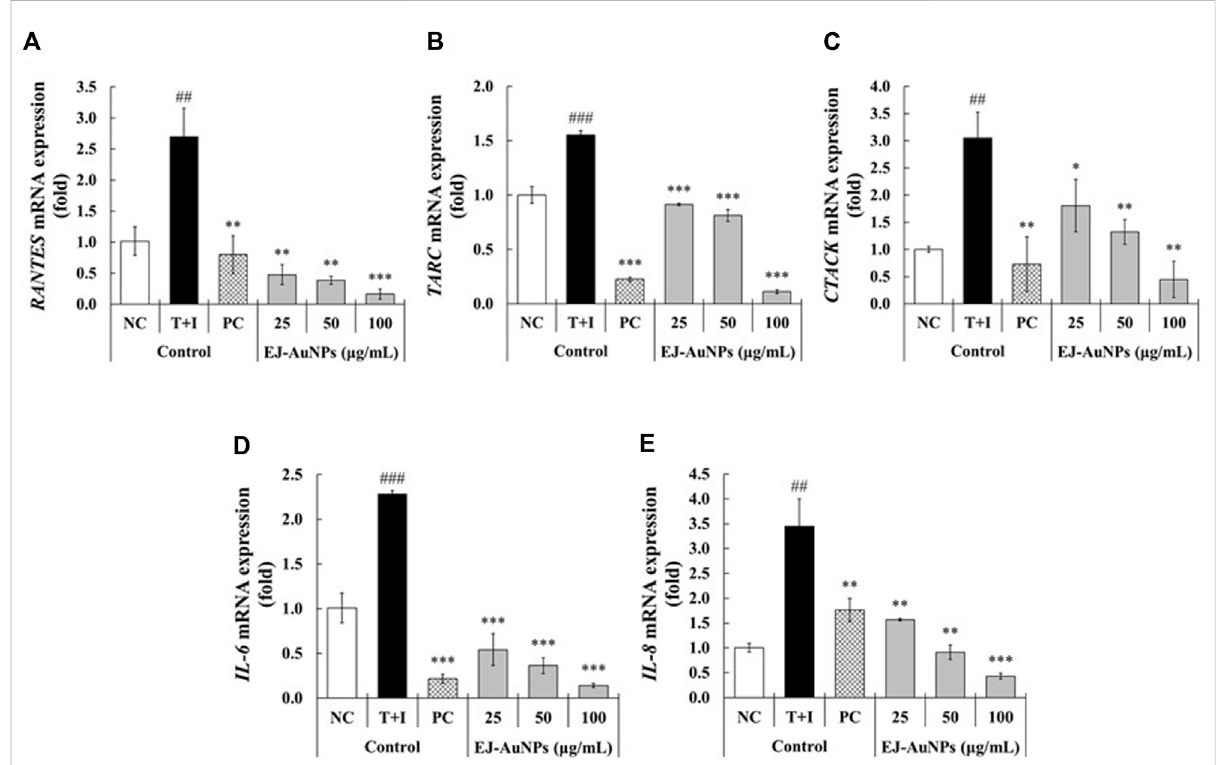
FIGURE 7 Effect of EJ-AuNPs on the expression levels of pro-in fl ammatory genes, including (A) C-C motif chemokine ligand 5 ( CCL5 )/regulated on activation, normal T cell expressed and secreted ( RANTES ), (B) thymus and activation-regulated chemokine ( TARC / CCL17 ), (C) cutaneous T-cell attracting chemokine ( CTACK / CCL27 ), (D) interleukin (IL)-6 , and (E) IL-8 / CXCL-8 , in the tumor necrosis factor-alpha and interferon-gamma (TNF- α andIFN- γ ;T+I)-treatedHaCaTkeratinocytes.NC,negativecontroltreatedwithmediumalone;T+I,in fl ammation-inducedcontroltreatedwith T+I alone; PC, positive control treated with dexamethasone (20 μ g/ml) followed by T+I stimulation. EJ-AuNPs, sample groups treated with EJ- AuNPs followed by T+I stimulation. The crosshatch marks indicate the signi fi cant differences between NC and T+I, and asterisks indicate the signi fi cant differences between T+I and each group. * p < 0.05; ** and ## , p < 0.01; *** and ### , p <